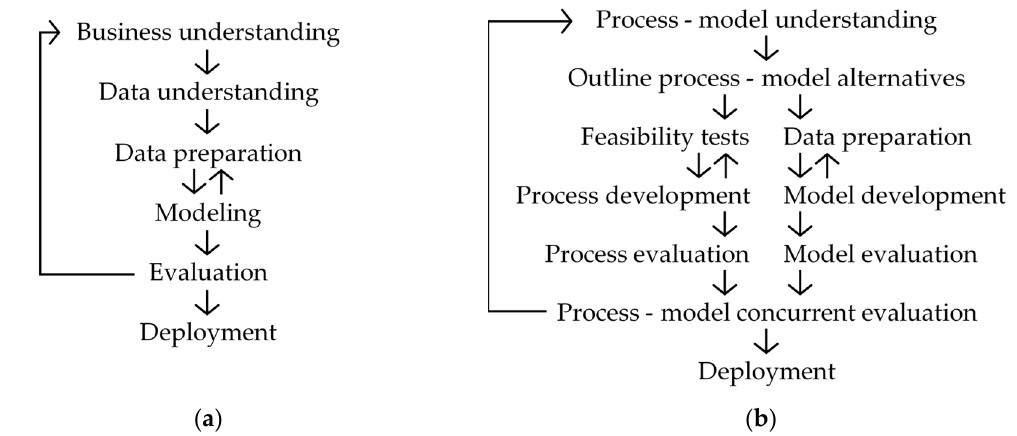
Figure 2. Comparison of methodologies: ( a ) the original CRISP-DM workflow; and ( b ) modified version adopted in this research for the combined development of processes and models (CDPM).